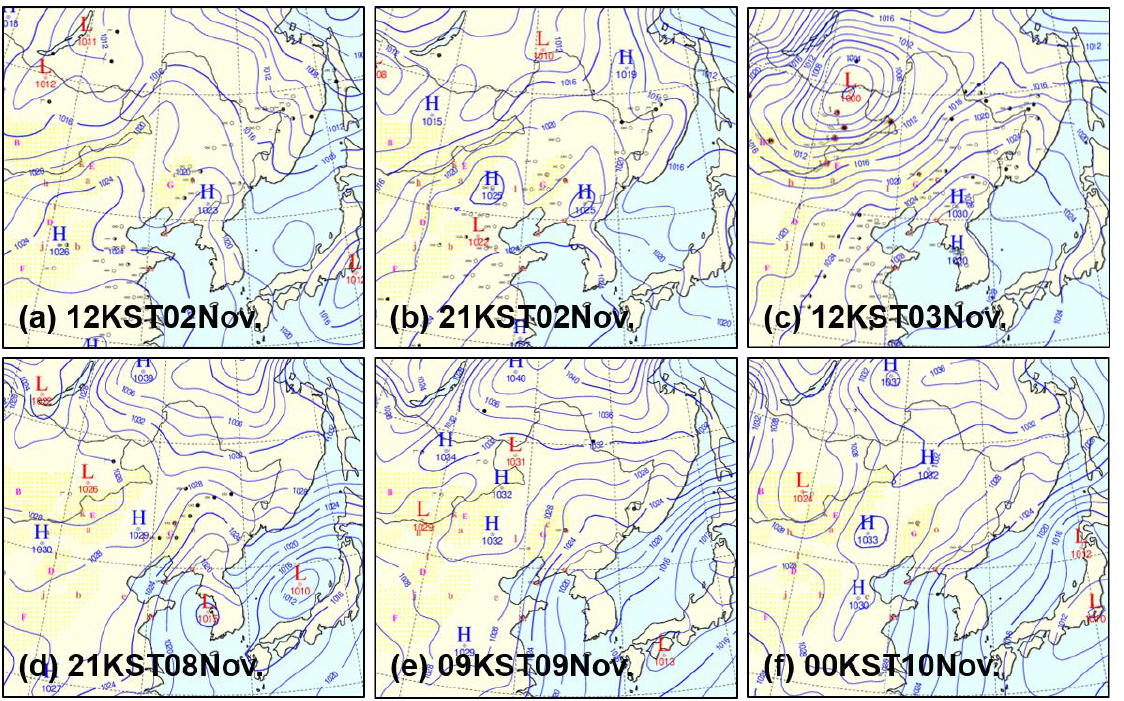
Figure 2. Meteorological conditions of northeast Asia from KMA in ( a – c ) Case 1 and ( d – f ) Case 2, 2015 (( a ) 2 November 12:00 KST; ( b ) 2 November 21:00 KST; ( c ) 3 November 12:00 KST; ( d ) 8 November 21:00 KST; ( e ) 9 November 09:00 KST; ( f ) 10 November 00:00 KST).